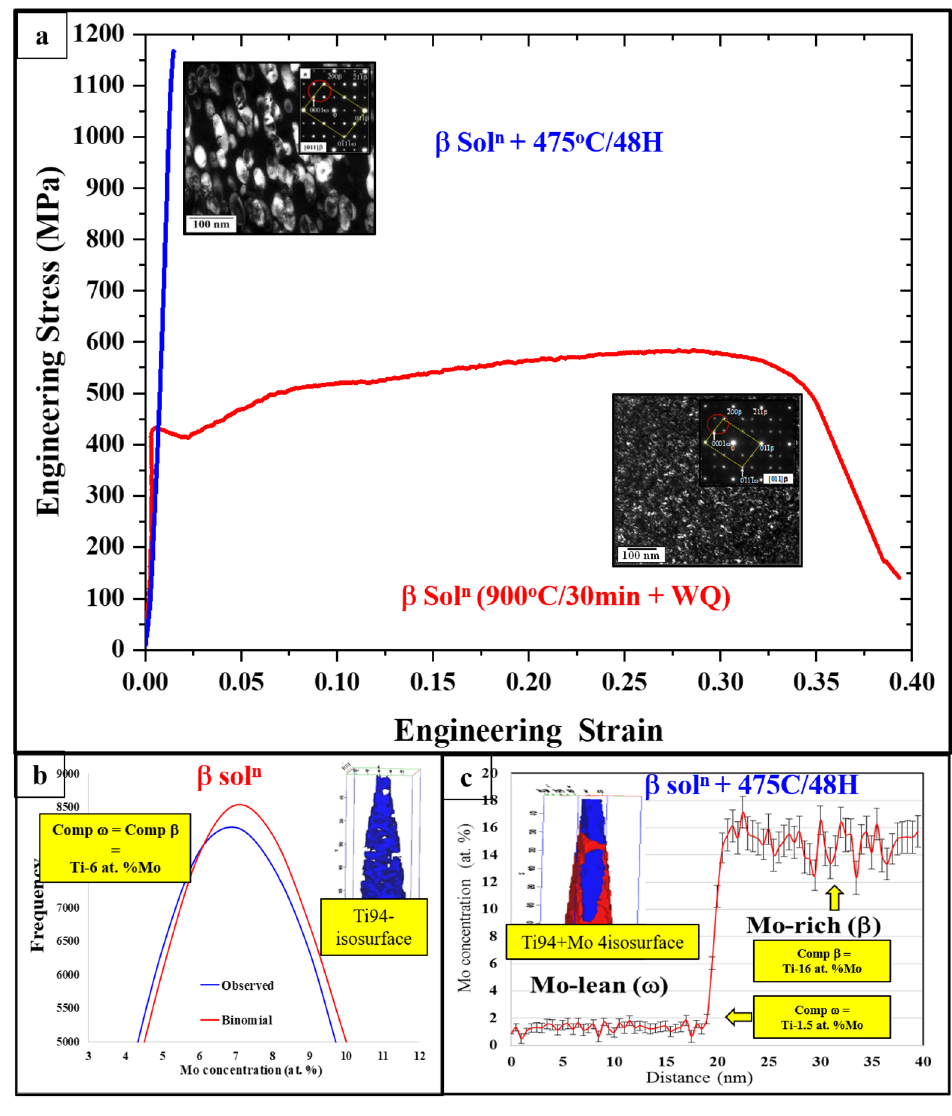
Figure 8. ( a ) Tensile test curves and Dark-field TEM (DFTEM) images of the β-solutionized condition (red curve) and the β-solutionized and annealed condition (blue curve). Insets show the [011] β electron diffraction patterns used for DFTEMs recording, ( b ) atom probe tomography (APT) results showing the binomial distribution comparison of Mo concentrations in β-solutionized specimen, ( c ) shows the 1D composition profile plot for Mo partitioning across ω/β interface (the inset shows the isoconcentration